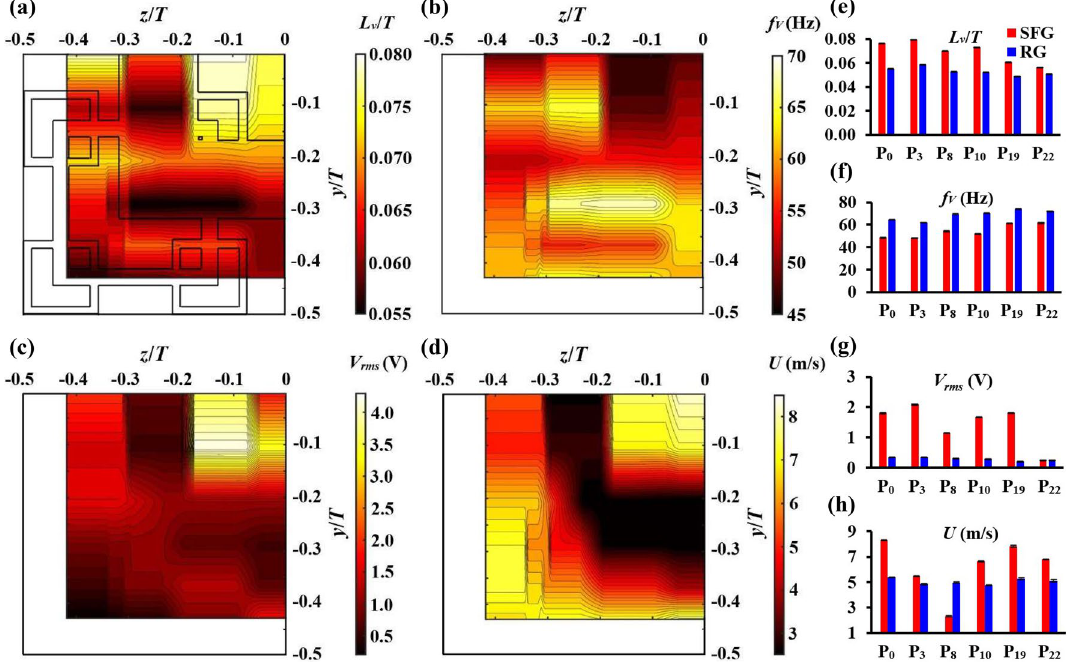
Figure 9. 2D contours of ( a ) L v / T , ( b ) f V , ( c ) V rms and ( d ) local mean velocity U at x / D h = 0.425 leeward of SFG, and ( e – h ) the corresponding results for RG at positions P 0 , P 3 , P 8 , P 10 , P 19 and P 22